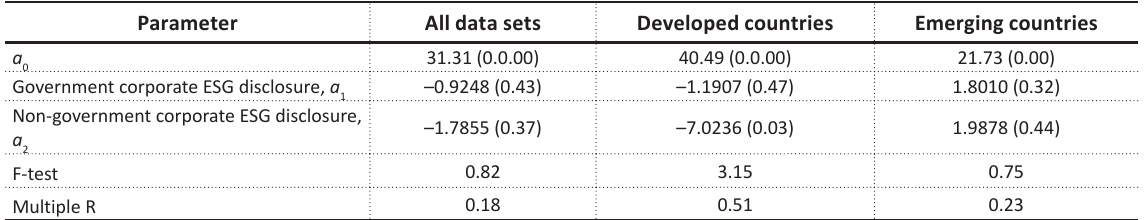
Table 8. Multiple regression analysis: ranking in 50 largest economies ( Y ) and ESG disclosure regulation ( X )